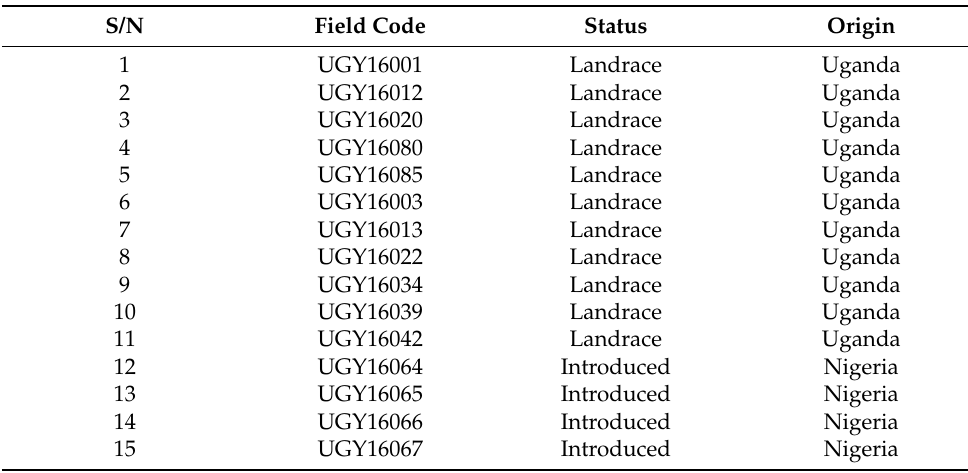
Table 1. List of yam ( Dioscorea spp.) genotypes used in the